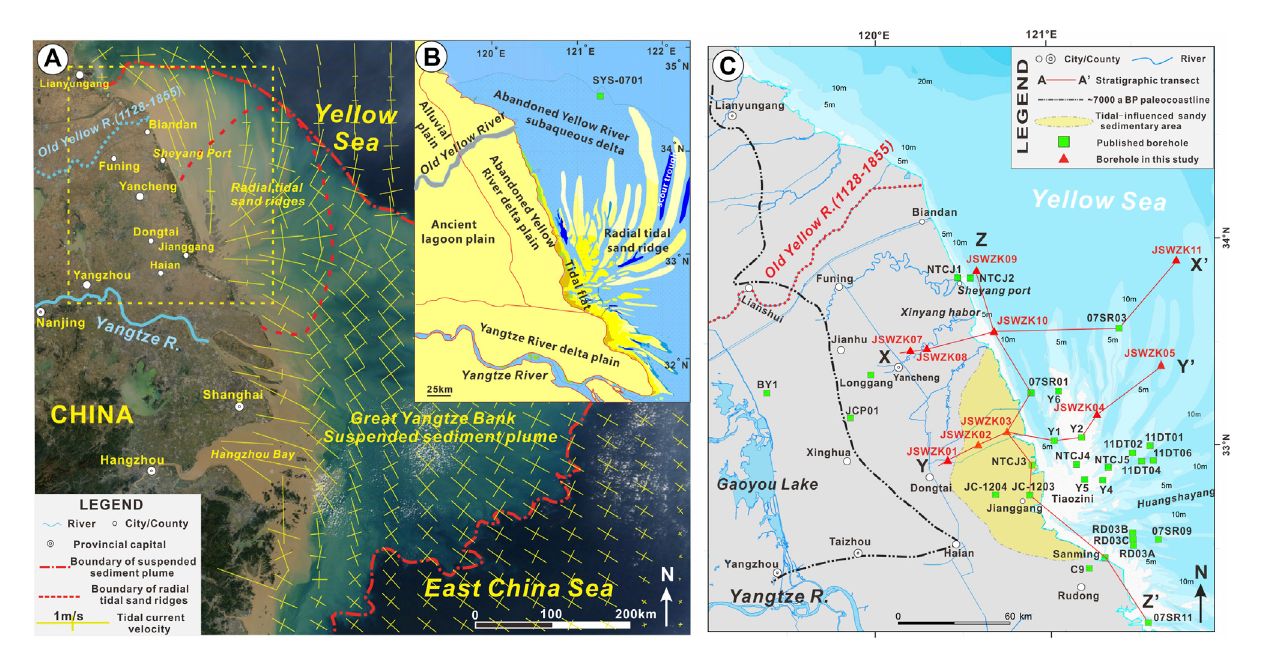
FIGURE 1 Radial tidal sand ridge and distribution of borehole data in this study. (A) Remote sensing satellite map of the Yellow Sea and East China Sea captured by NASA ’ sTerra satellite at 9November 2017. Notice that thesuspended sedimentplume of the great Yangtzebank and radial tidal sand ridges is outlined bythe red dashed – dotted line and the dotted line, respectively. The yellow cross lines represent the distribution of M2 current ellipses (crosses) and magnitudes of semi-major axes (Uehara et al., 2002). (B) Schematic map of geological sedimentary units in the study area, modi fi ed from Li et al. (2001) and Xue et al. (2010). (C) Distributionof10boreholesandotherpreviouslypublishedboreholesinthenorthJiangsucoastalplainandintheradialtidalsandridgeregion.The black dashed – dotted line represents the limit of the Holocene maximum transgression in the northern Jiangsu Coast (Xue et al., 2010). The red dashed line indicates the old Yellow River course between 1128 and 1855